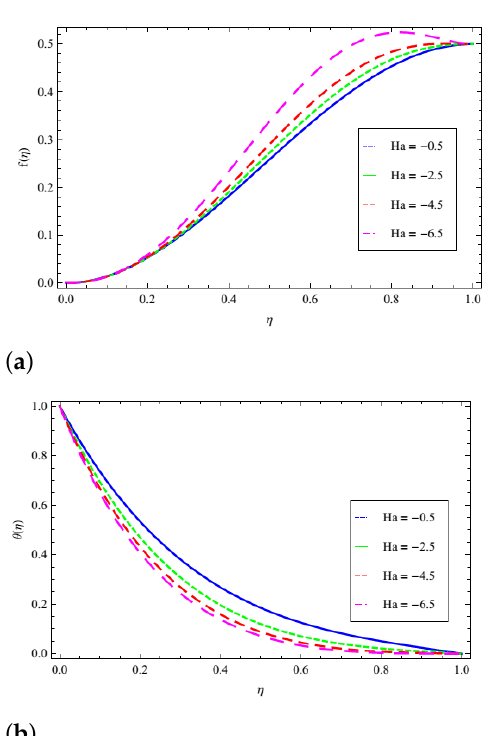
Figure 4. Impact of Ha on ( a ) velocity component f ( η ) and ( b ) heat distribution variable θ ( η ) for